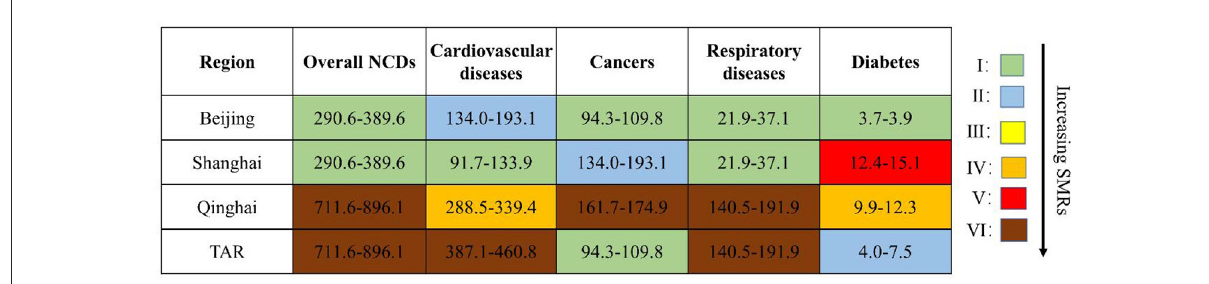
FIGURE4 Comparison of SMRs due to four major NCDs in Beijing, Shanghai, Qinghai, and TAR in 2019 (deaths per 100,000 population). Overall NCDs: I: 290.6–389.6; II: 389.7–494.0; III: 494.1–595.1; IV: 595.2–651.7; V: 651.8–711.5; VI: 711.6–896.1. Cardiovascular diseases: I: 91.7–133.9; II: 134.0–193.1; III: 193.2–288.4; IV: 288.5–339.4; V: 339.5–386.9; VI: 387.1–460.8. Cancers: I: 94.3–109.8; II: 109.9–124.5; III: 124.6–134.9; IV: 135.0–146.6; V: 146.7–161.6; VI: 161.7–174.9. Respiratory diseases: I: 21.9–37.1; II: 37.2–49.9; III: 50.0–58.8; IV: 58.9–88.6; V: 88.7–140.4; VI: 140.5–191.9. Diabetes: I: 3.7–3.9; II: 4.0–7.5; III: 7.6–9.8; IV: 9.9–12.3; V: 12.4–15.1; VI: 15.2–19.7. SMR, standardized mortality rate; TAR, Tibet Autonomous Region; NCD, non-communicable disease. Data were from the Report on Chronic Disease Risk Factor Surveillance in China (2020).